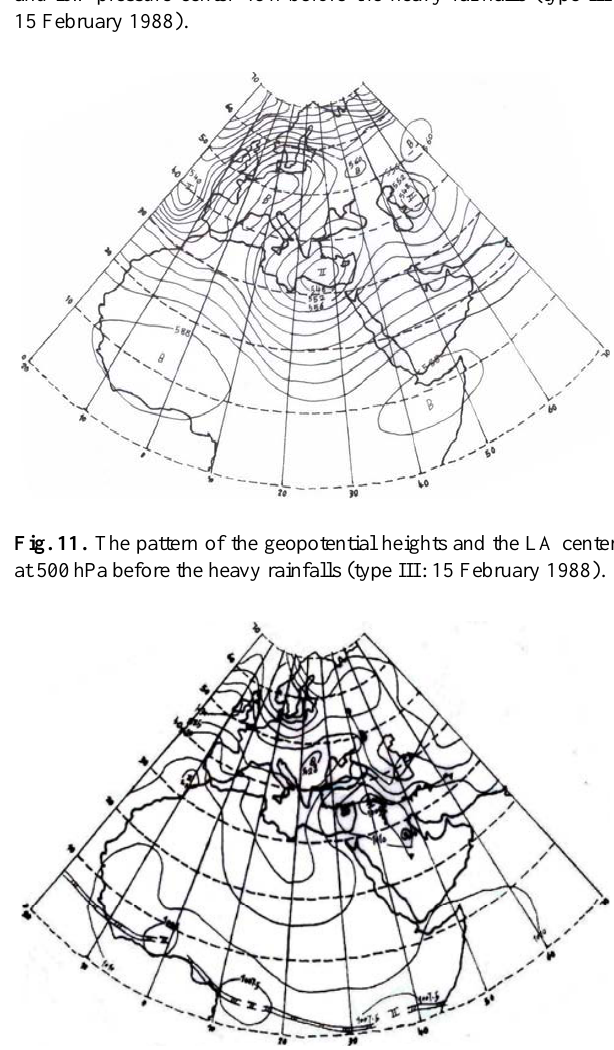
Fig. 12 The pattern of the surface (AAXX) Mediterranean frontal cyclone during the Fig. 12. The pattern of the surface (AAXX) Mediterranean frontal cyclone during the heavy rainfalls (type III: 17 February 1988).